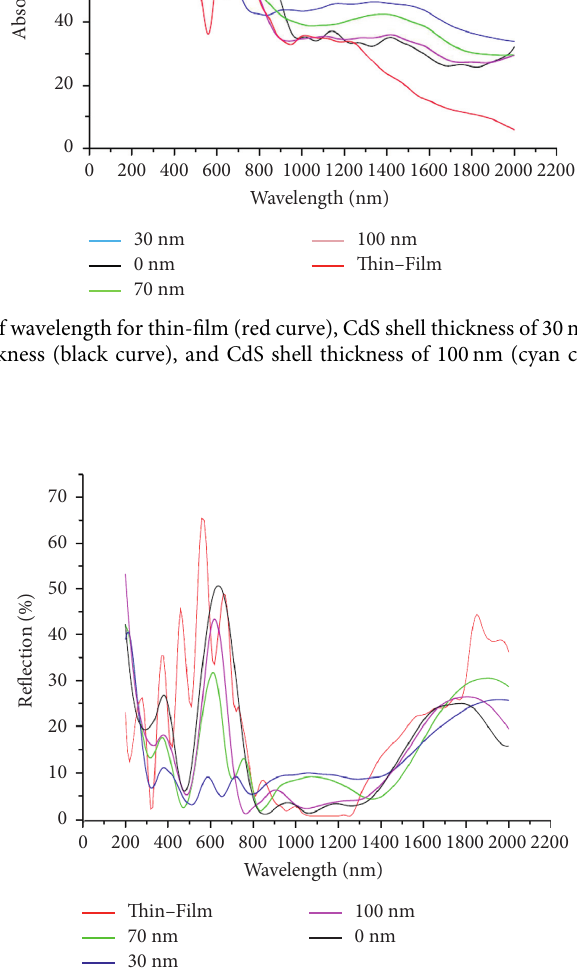
Figure 6: Reflection as a function of wavelength for thin-film (red curve), CdS shell of 30nm (blue curve), CdS shell of 70nm (green curve), CdS shell thickness (black curve), and CdS shell of 100nm (light blue curve).